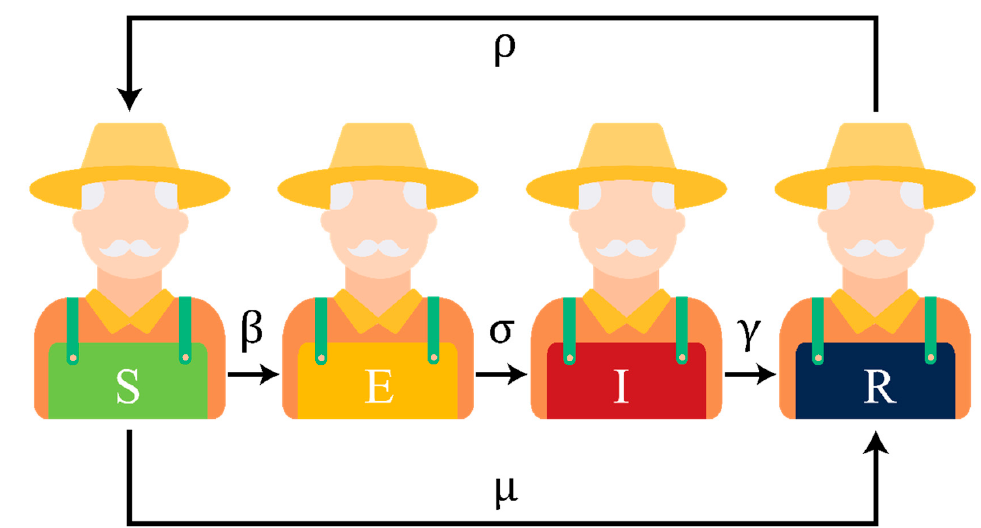
Figure 2. Diagram of cultivated land protection policies (CLPP) dissemination. Table 1. Concept correspondence.